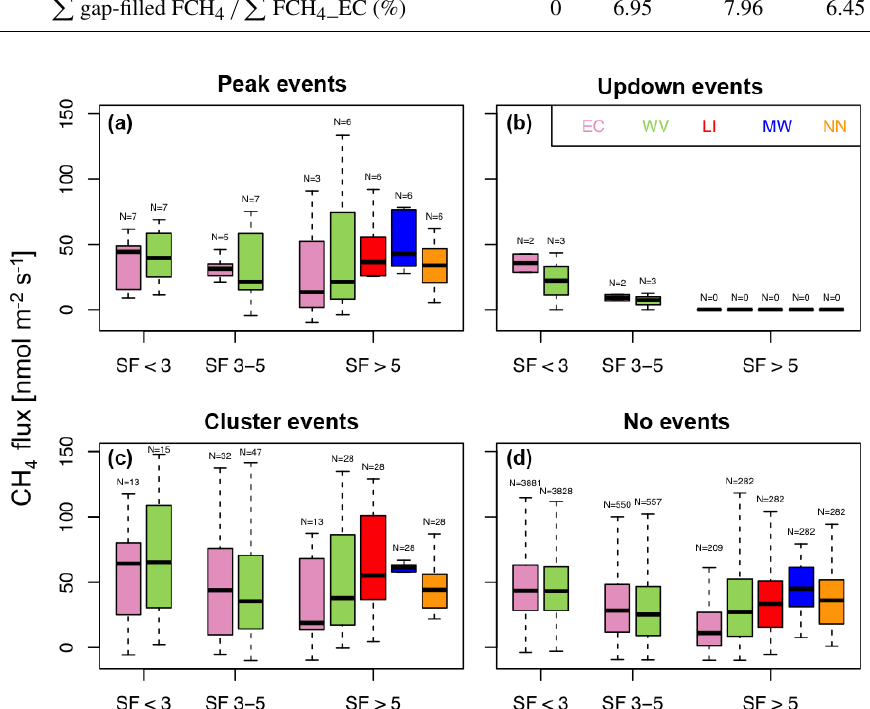
Figure 4. Methane fluxes based on the EC (pink) and wavelet (green) flux processing method for three stationarity flag (SF) categories during different event types at tower 2. For SF > 5, where methane fluxes based on the EC method would be excluded during the regular post-processing quality control, in addition the values for the three gap-filling methods (red: LI; blue: MW; orange: NN) are shown. For details on graph features, please refer to Fig.